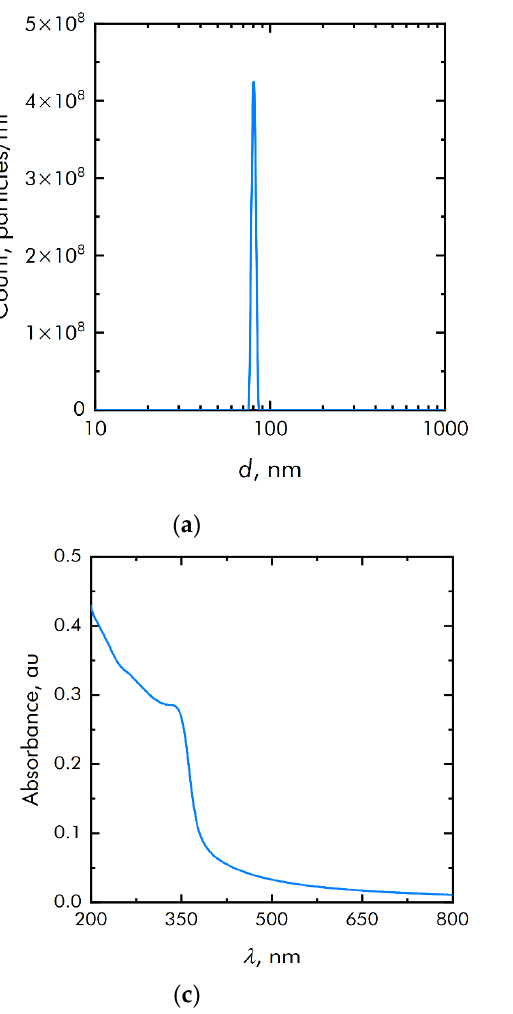
Figure 2. Physicochemical properties of zinc oxide nanoparticles: ( a ) Concentration and size distribution of zinc oxide nanoparticles; ( b ) Zeta potential of zinc oxide nanoparticles; ( c ) Optical absorption of an aqueous colloidal solution of zinc oxide nanoparticles; ( d ) TEM image of a group of zinc oxide nanoparticles (image used by the authors earlier in other manuscripts).